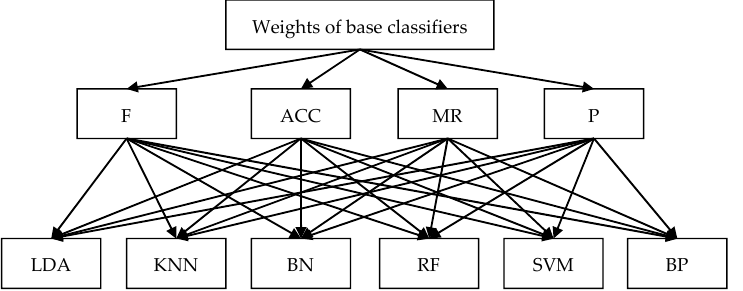
Figure 2. Hierarchy of the AHP. BN: Bayesian classifier; RF: random forest; F: F-value; ACC: Accuracy; MR: Missing Rate; P: